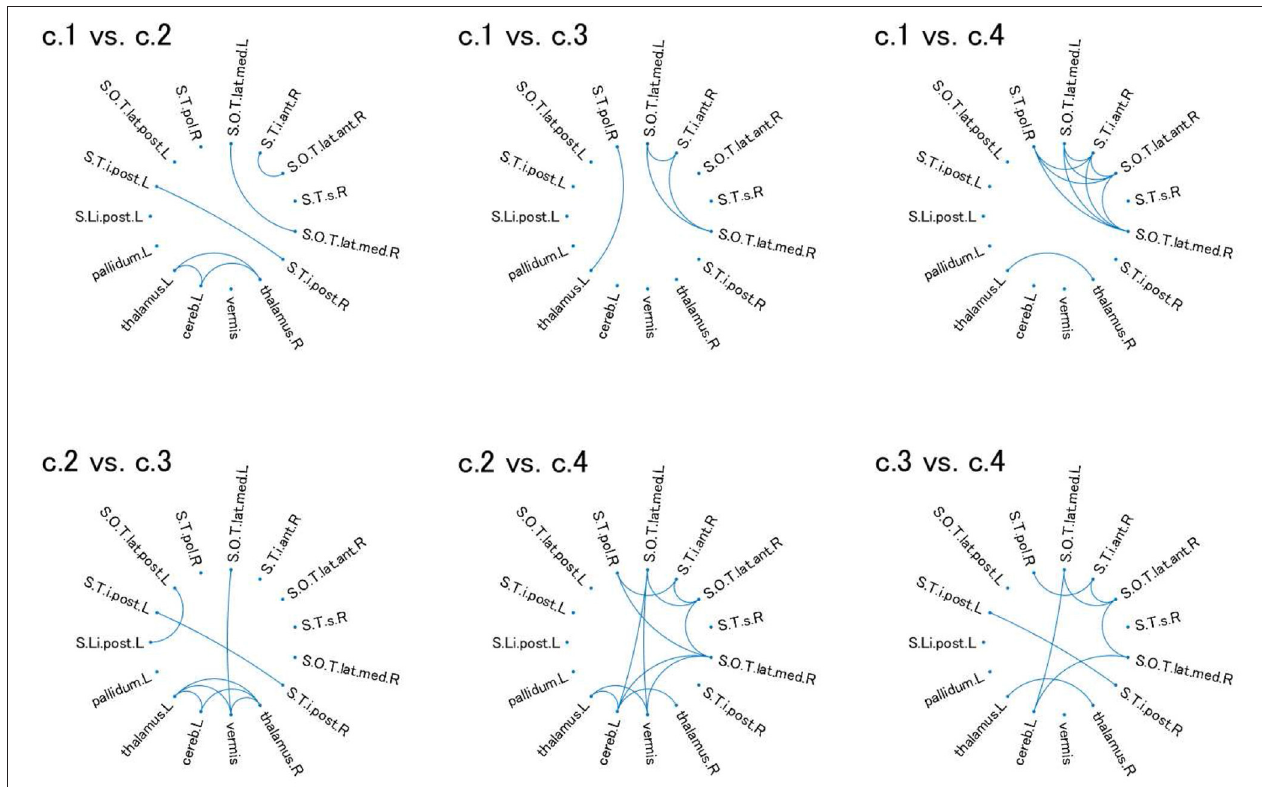
FIGURE 4 | Relevant connectivity for differences between pairs of the four clusters in view 4. The relevant connectivity for the difference between cluster i and cluster j is displayed in panel “c. i vs. c. j .” The relevance of connectivity is evaluated by Cohen’s d for the effect size of FC differences between two clusters. The connectivity with d > 0.8 [large separability; ( 39)] is shown in the diagram in which the ROI is denoted as a dot. S.Li.post.L, left posterior intra-lingual sulcus; S.O.T.lat.ant.R, right anterior occipito-temporal lateral sulcus; S.O.T.lat.med.L, left median occipito-temporal lateral sulcus; S.O.T.lat.med.R, right median occipito-temporal lateral sulcus; S.O.T.lat.post.L, left posterior occipito-temporal lateral sulcus; S.T.i.ant.R, right anterior inferior temporal sulcus; S.T.i.post.L, left posterior inferior temporal sulcus; S.T.i.post.R, right posterior inferior temporal sulcus; S.T.pol.R, right polar temporal sulcus; S.T.s.R, left superior temporal sulcus; thalamus.L, left thalamus; pallidum.L, left pallidum; thalamus.R, right thalamus; cereb.L, left cerebellum; vermis, vermis. For visualization of these brain regions, see Supplementary Figure 2